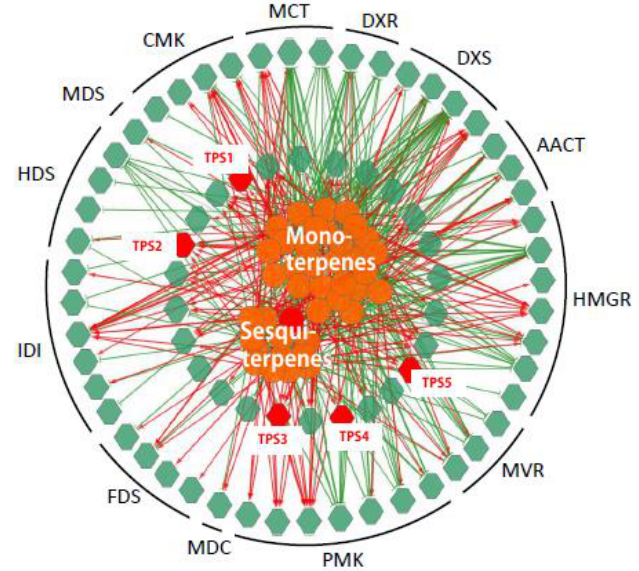
Figure 4. Correlation networks generated by the integration of expression levels of genes and terpenoids accumulation. The networks were generated by the integration of the expression levels (reads per kilobase per million (RPKM) value) of 75 (of 82) genes (green hexagons) and the accumulation of 41 terpenoids (orange circulars) using Pearson partial correlation analysis (r > 0.8 or r < −0.8, p < 0.05). Red hexagons, genes related to farnesene, named TPS1-5 . Red links, positive correlation (r > 0.8): green links, negative links (r < −0.8).